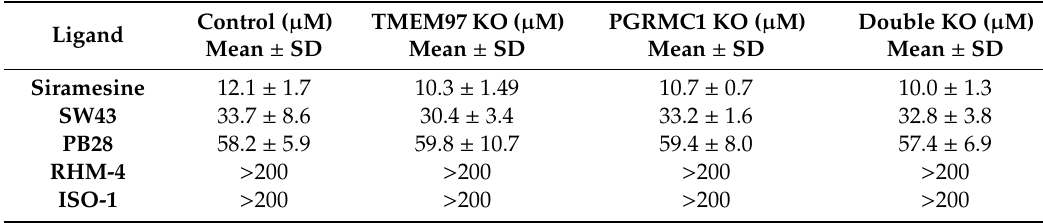
Table 1. EC 50 values of s2R ligands in control, TMEM97 KO, PGRMC1 KO and double KO cell